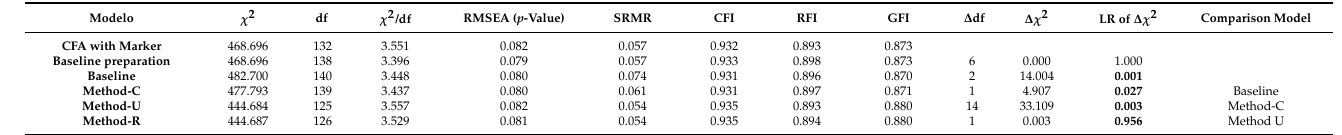
Table 7. Common method variance